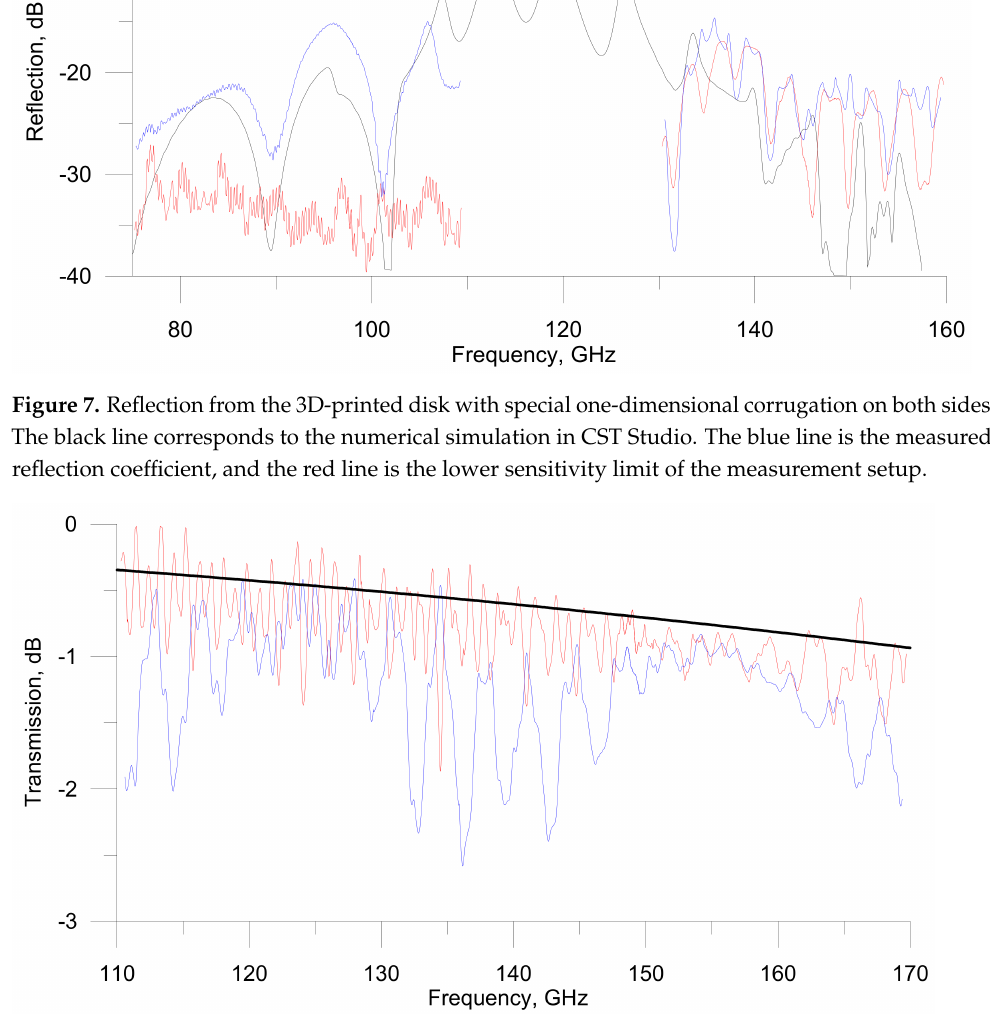
Figure 8. Transmission through the disks. The red line corresponds to the disk with pyramids on both sides, and the blue line corresponds to the flat-surface disk. The black line shows dielectric losses calculated in the 3.33 mm thick polyamide disk with zero